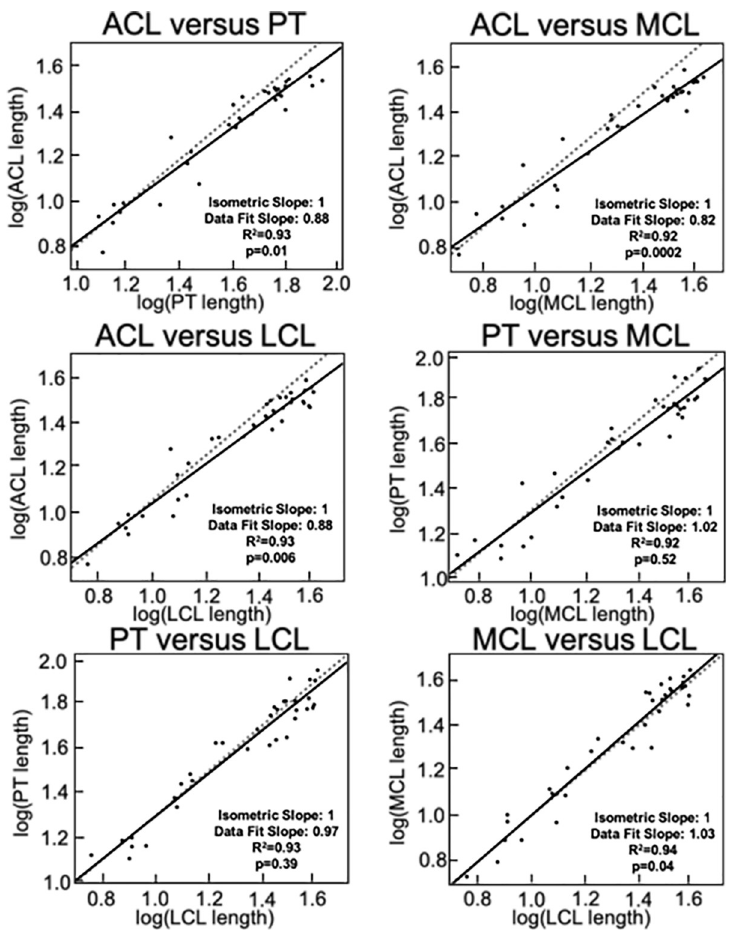
Fig 7. Comparisons of tissue length reveal differing rates of growth between the tissues. In these plots, the dashed line represents the line of isometry while the solid line represents the line of best fit for the data points (R 2 values provided, p < 0.05 denote statistical difference from isometric line, slopes denote standard and best fit lines).